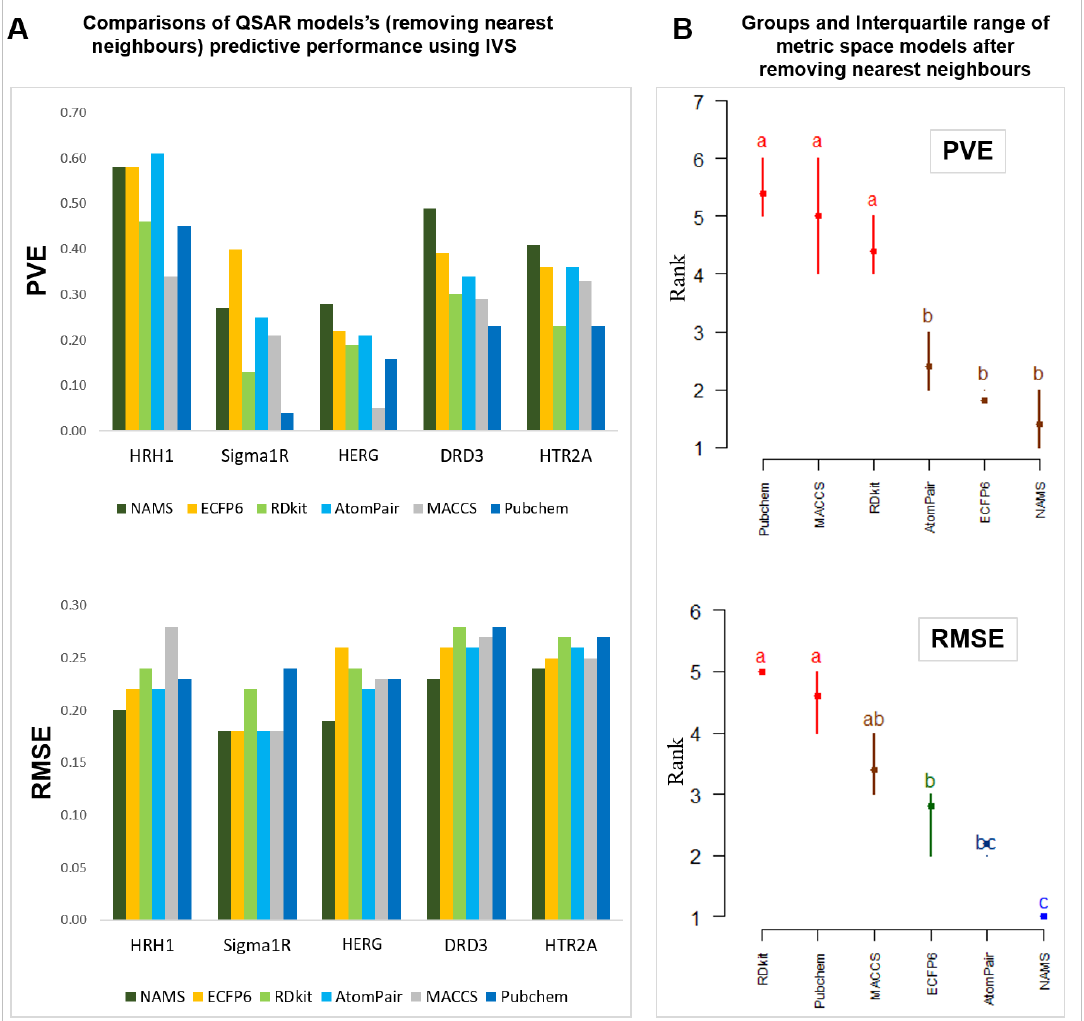
Figure 7. Overall performance of metric space representation after removing nearest neighbors in a PCA on metric space-based QSAR modeling